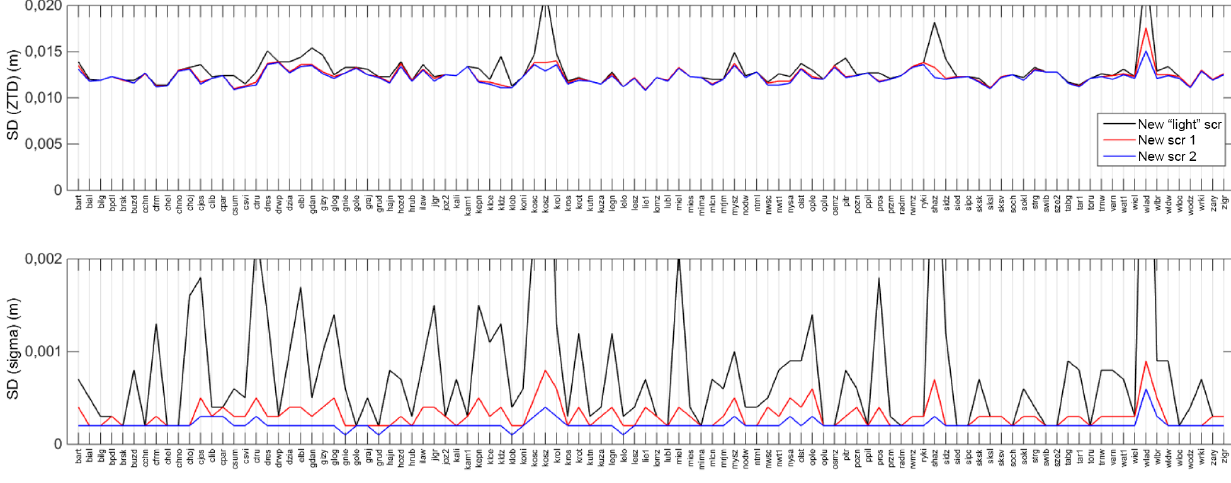
Figure 12. Distribution of standard deviations of ZTD forward differences and formal error of ZTD at 104 common ASG-EUPOS stations, for the new processing strategy and different screening variants (see text).